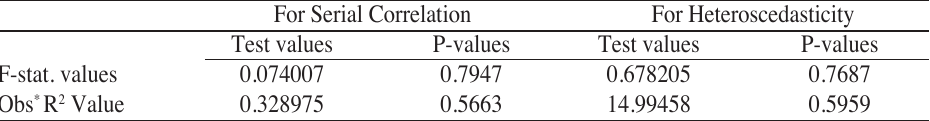
BG and BGP Test Results